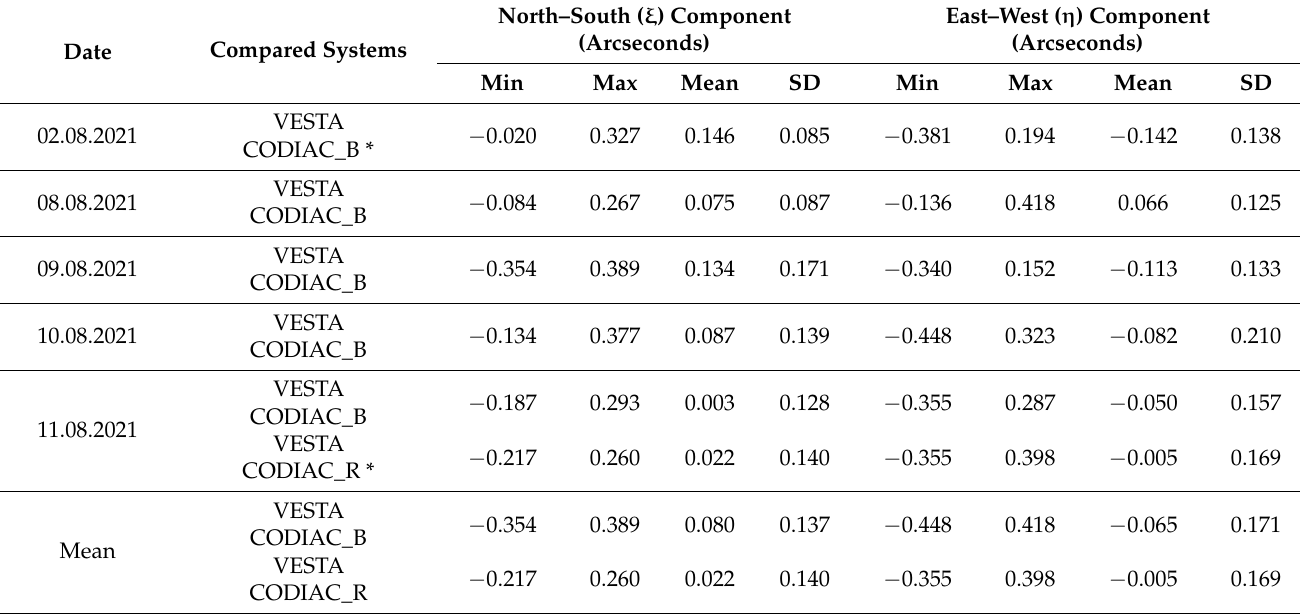
Table 4. Differences between VESTA and CODIAC observed DoVs, and corresponding